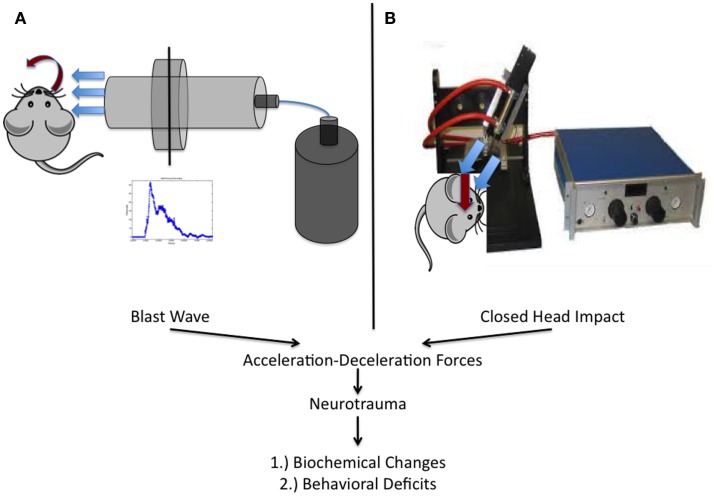
Schematic representation of the two injury models utilized within this work. (A) Experimental setup utilized at West Virginia University for the study of blast-induced neurotrauma. The shock tube consists of a high-pressure driver section (nitrogen gas filled) and a low-pressure driven section (ambient air filled). When the membrane dividing the chambers ruptures, the blast wave is formed and released, encountering the rat from the right side of the cranium. (B) Depiction of the model utilized at the University of Rochester in unanesthetized mice. An electromagnetic impactor used in CCI was modified with a rubber tip and a specially designed helmet was placed on the mouse as previously described.